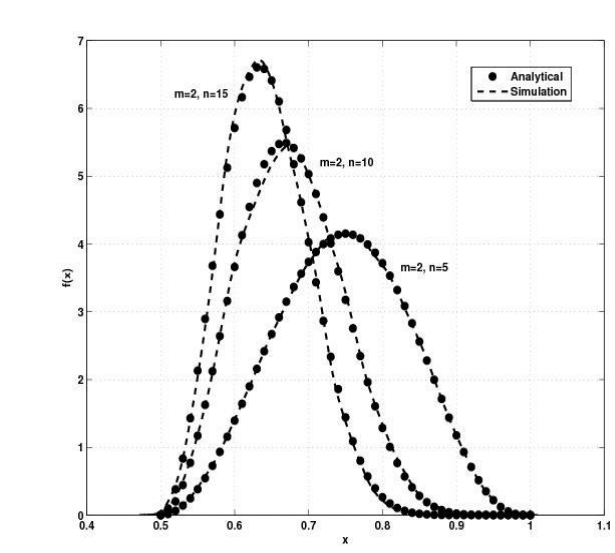
Figure 7. The PDF of the ratio of the largest eigenvalue to the trace of a uncorrelated dual complex Wishart matrix.